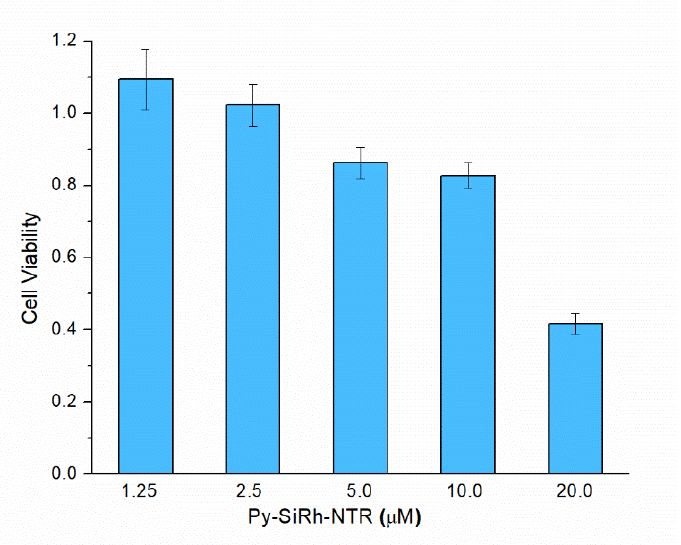
Figure 3. Cytotoxicity of Py-SiRh-NTR in cultured HepG-2 cells. Cell viability was measured by MTS assays, and the results were reported as percentage relative to untreated cells (mean ± SD).